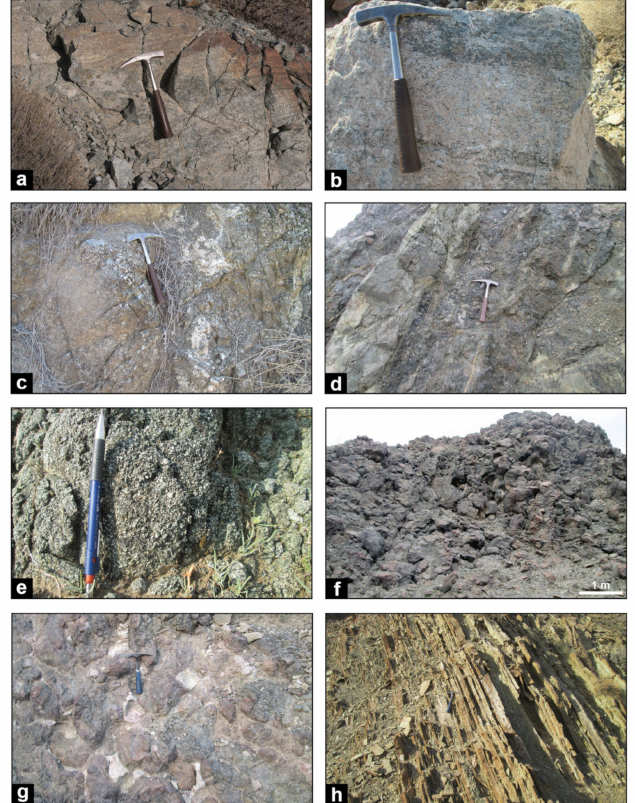
Figure 3. Field occurrence of the Band-e-Zeyarat ophiolite: ( a ) cumulitic gabbros from the layered gabbro, ( b ) close up of primary magmatic banding defined by the alternation of leucogabbro and gabbro, ( c ) gabbro from the isotropic gabbro, ( d ) vertical and parallel dykes from the sheeted dyke, ( e ) close up of the doleritic texture of an individual dyke from the sheeted dyke, ( f ) pillow lava flows from the volcanic sequence, ( g ) pillow breccia with clasts of whitish limestone, and ( h ) alternating thin beds of limestone and marl from the pelagic sedimentary